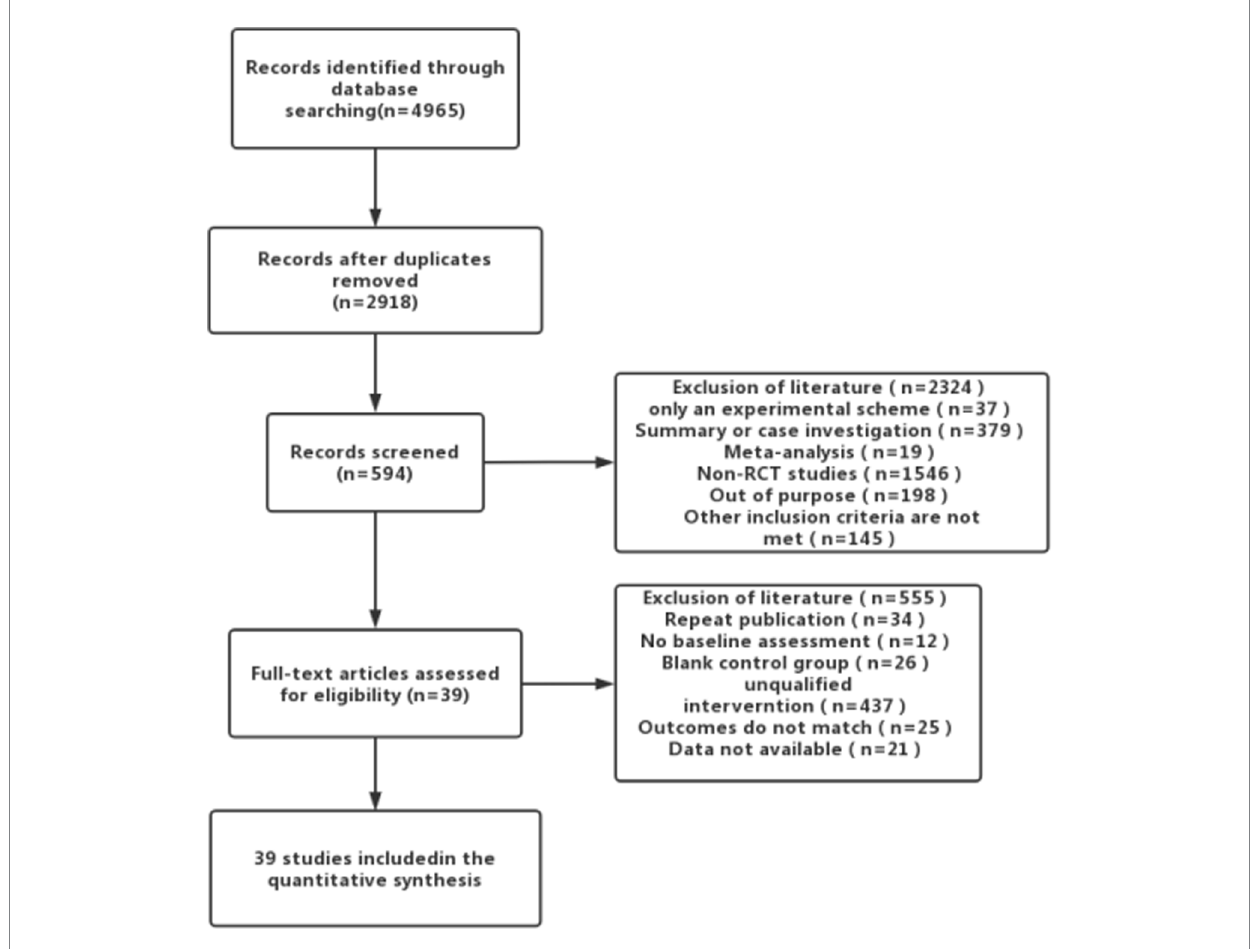
FIGURE 1 Process of literature search results and study